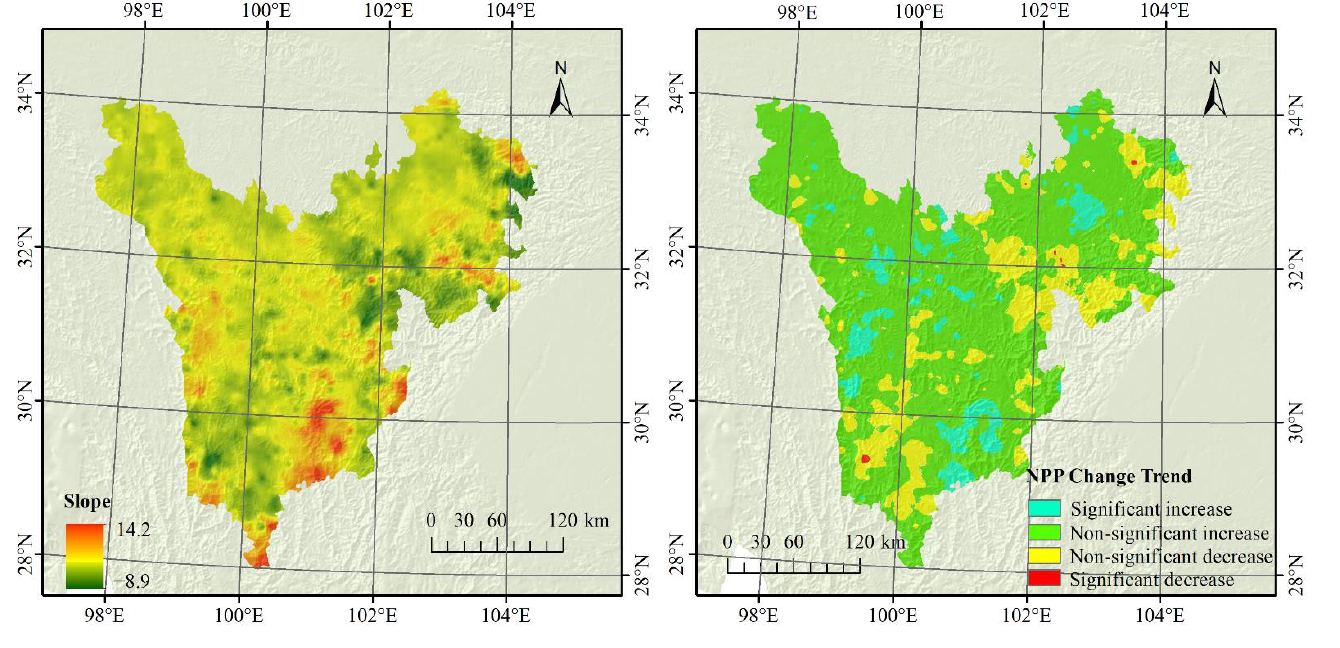
Figure 8. Spatial variation trend of VNPP and significance test.